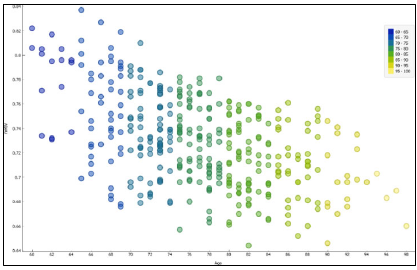
Fig. 3. Correlation between age and normalized whole brain volume (nWBV)